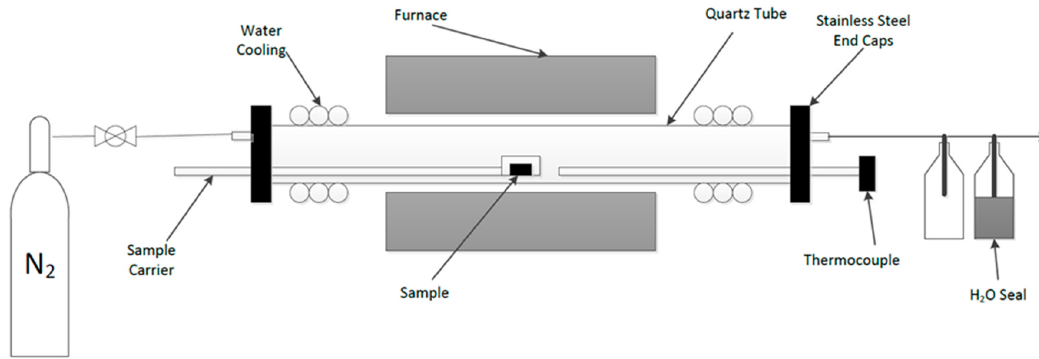
Figure 6. Schematic diagram of the tube furnace.